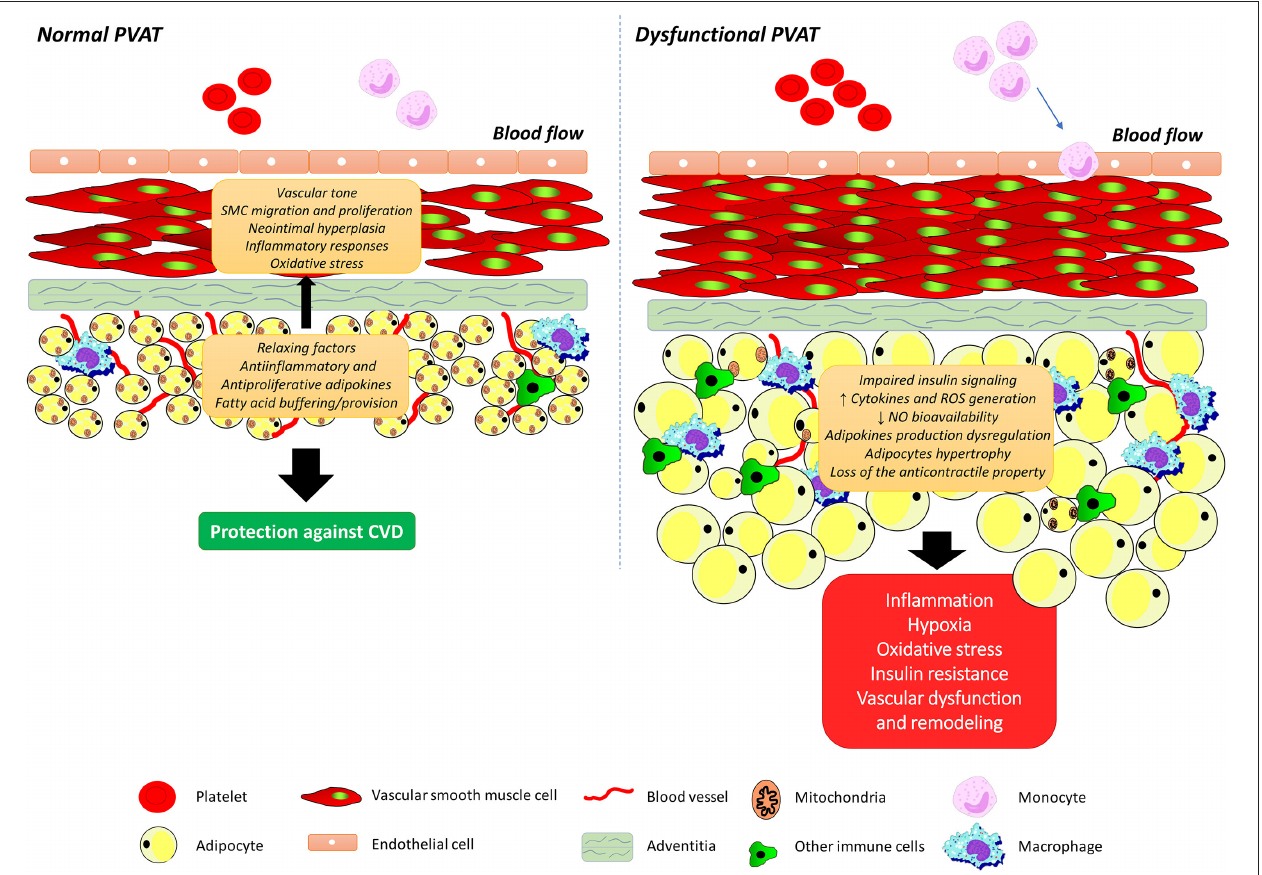
FIGURE 2 | Perivascular adipose tissue dysfunction and obesity-associated vascular dysfunction . Perivascular adipose tissue (PVAT) secretes a wide variety of biologically active molecules, including the adipokines, which modulate vascular tone, smooth muscle cells migration and proliferation, neointimal hyperplasia, inflammatory responses, and oxidative stress. Obesity is associated with structural and functional changes in PVAT, leading to an imbalance in favor of vasoconstrictor and pro-inflammatory substances, adipocytes hypertrophy as well as changes in insulin signaling pathways. SMC, smooth muscle cell; ROS, reactive oxygen species; NO, nitric